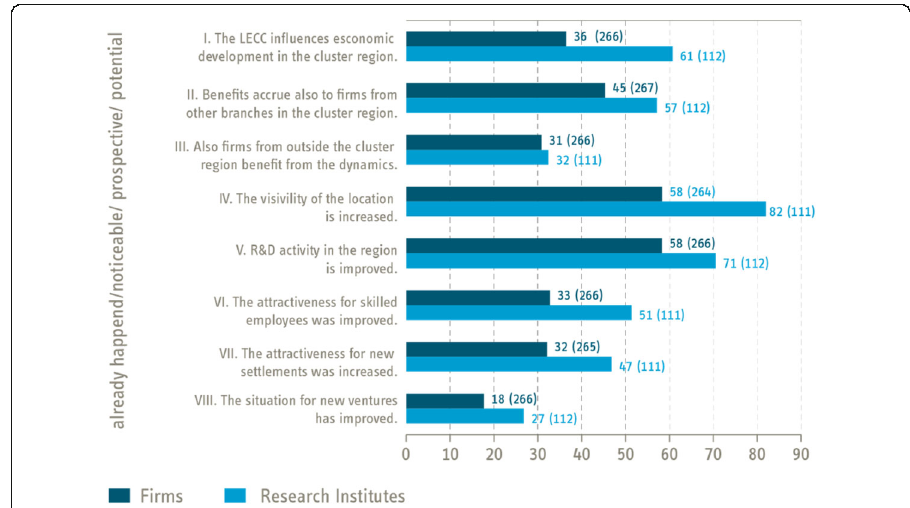
Fig. 9 Impact of the Leading-Edge Cluster Competition on the development of the cluster regions. Source: Accompanying evaluation of the LECC; written survey of LECC-funded organisations in the clusters of the first competition round in 2012 and the second competition round in 2013. – Comments: Percentage of actors who responded with a “ 1 ” or “ 2 ” on a scale from 1 (completely agree) to 5 (disagree). The items in the two categories “ prospective/potential ” and “ already happened/noticeable ” are arranged in descending order of importance. The number of responses (n) is given in